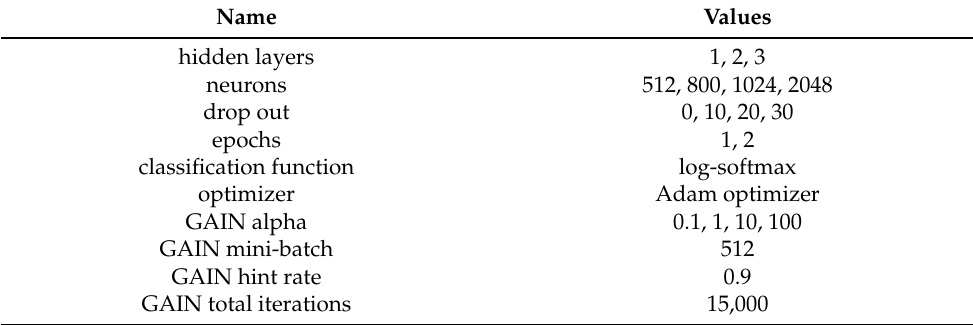
Table 3. Neural Network Parameters.